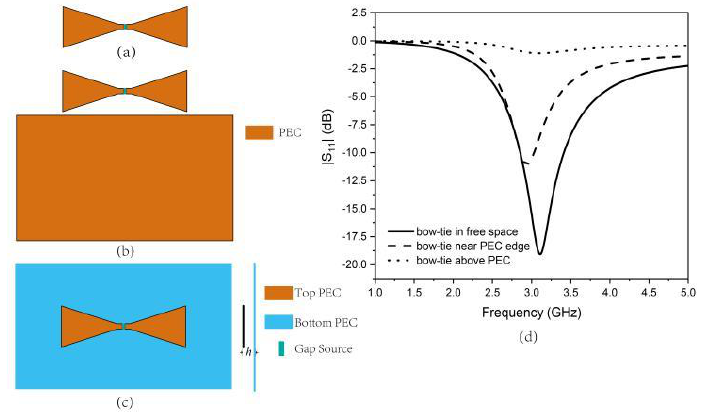
Figure 3. Geometries of ( a ) bow-tie radiator in free space, ( b ) bow-tie radiator near the edge of a ground plane and ( c ) bow-tie radiator above a ground plane. ( d ) Simulated return losses of ( a – c ).